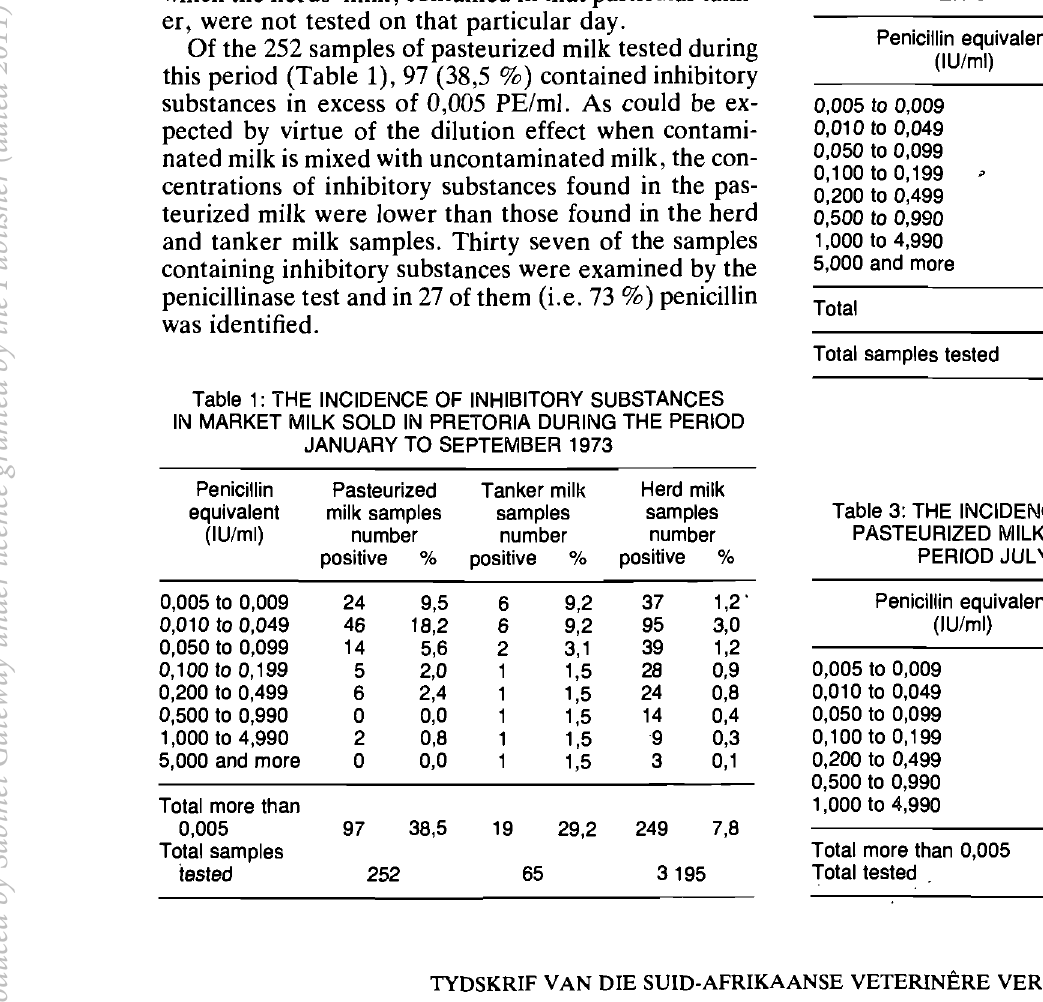
Table 1: THE INCIDENCE OF INHIBITORY SUBSTANCES IN MARKET MILK SOLD IN PRETORIA DURING THE PERIOD